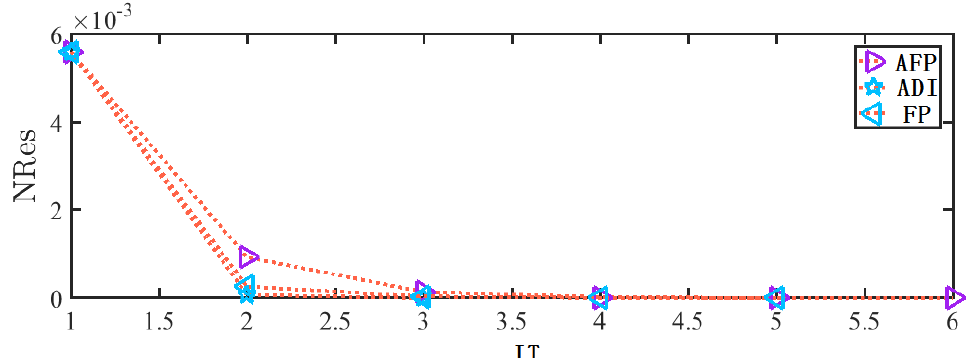
Figure 6. The relation of IT and NRes for the three algorithms when P 0 = ˜ P 1